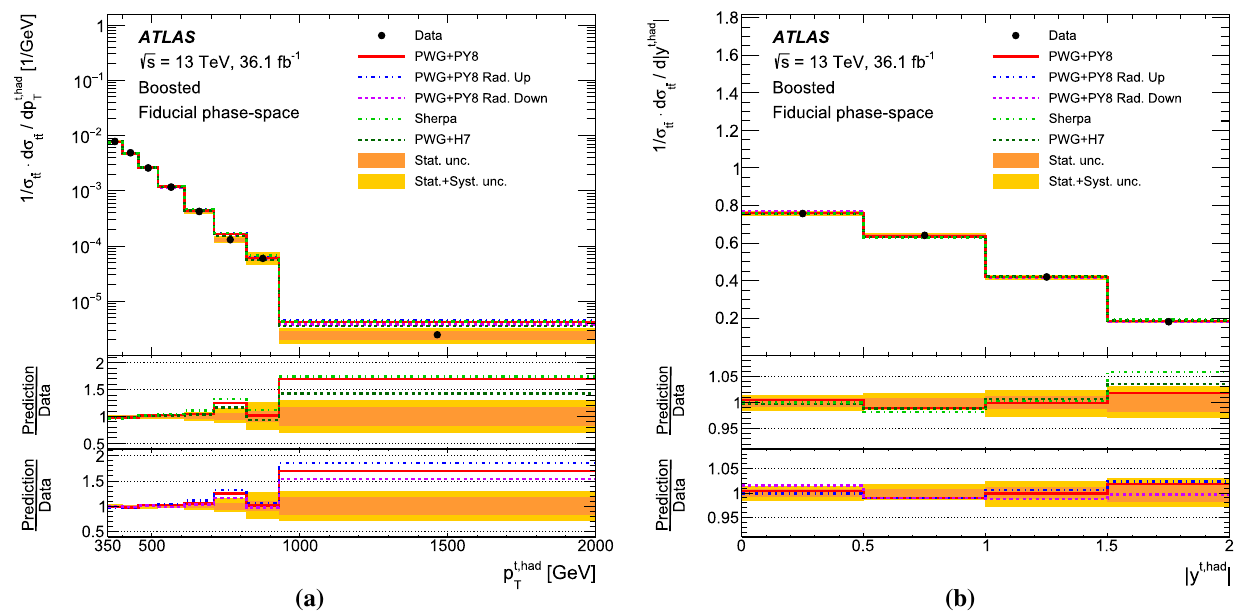
Fig. 37 Particle-level normalised differential cross-sections as a func- tion of a the transverse momentum and b the absolute value of the rapidity of the hadronically decaying top quark in the boosted topol- ogy, compared with different Monte Carlo predictions. The bands rep-